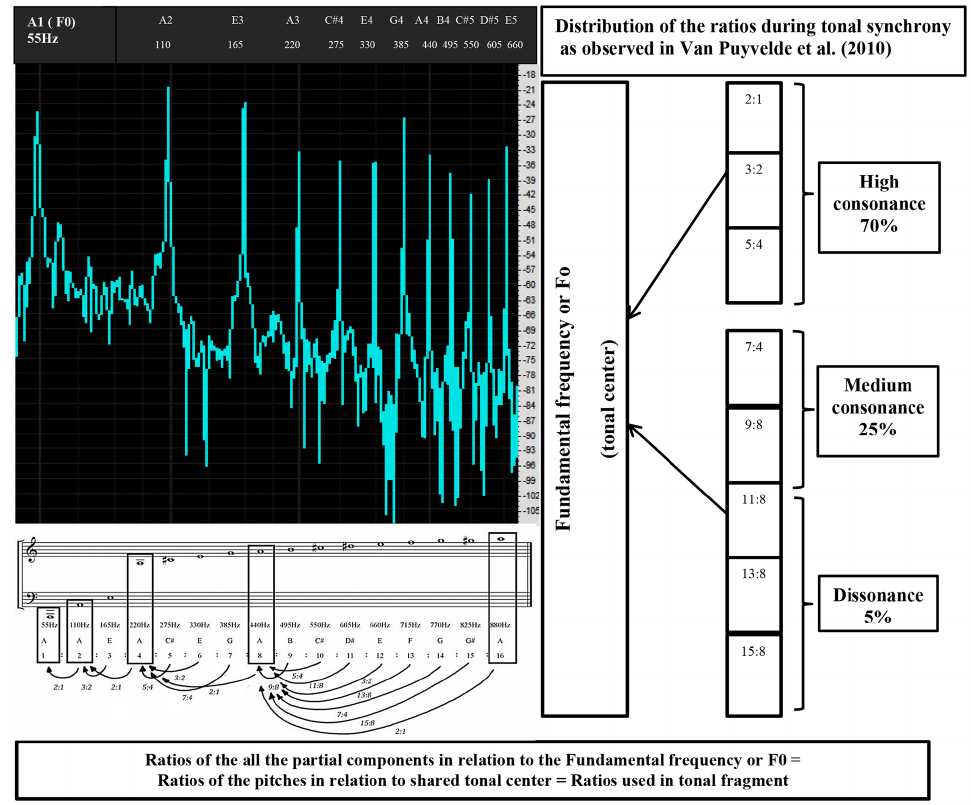
Figure 1. Illustration of a spectral analysis (multiple peak sounds within one tone) of a 55 Hz pitch tone. A regular sound vibration is a complex tone that consists of a fundamental frequency (F0 or harmonic number 1, h1 or A1 on the Figure, i.e., most left peak) + a series of harmonics or partials (h2–16, other peaks). Together, they blend, giving the impression of one single tone. The frequency of each partial is a multiple of the F0 (55–110–165 Hz and so forth…). These multiple relations are expressed in ratios on the Figure. For example h3 (165 Hz) is related to h2 (110 Hz) with a ratio of 3:2. When considering the harmonics h2–16 in relation to the F0, you obtain the illustrated frequency ratios (see on the bottom of the Figure). Van Puyvelde et al. (2010) observed that, during tonal synchrony, mothers and infants share a tonal center (which corresponds with F0/h1 and its octaviations) to which their other uttered pitches are related in the same fashion as the partials of a harmonic series are related to the fundamental frequency or F0 (i.e., the mothers and infants use the same ratios as pictured on the Figure). The partials of the tonal center are indicated by rectangles and the arrows show the frequency ratios with regard to this tonal center. For example h6 is related to h4 (ratio 6:4=3:2) and not h5 because h5 is not part of the tonal center (no octaviation of F0). On the right, an overview of the distribution of the ratios during tonal synchrony and their approximated music interval is given, with a distinction between high consonance (2:1, octave; 3:2, perfect 5; 5:4 major 3) medium consonance (7:4, minor 7; 9:8, major 2) and dissonance (11:8, triton; 13:8, minor 6; 15:8 major 7). The same ratios and distribution were used in the tonal fragment, i.e., 70% high, 25% medium consonance and 5% dissonance).